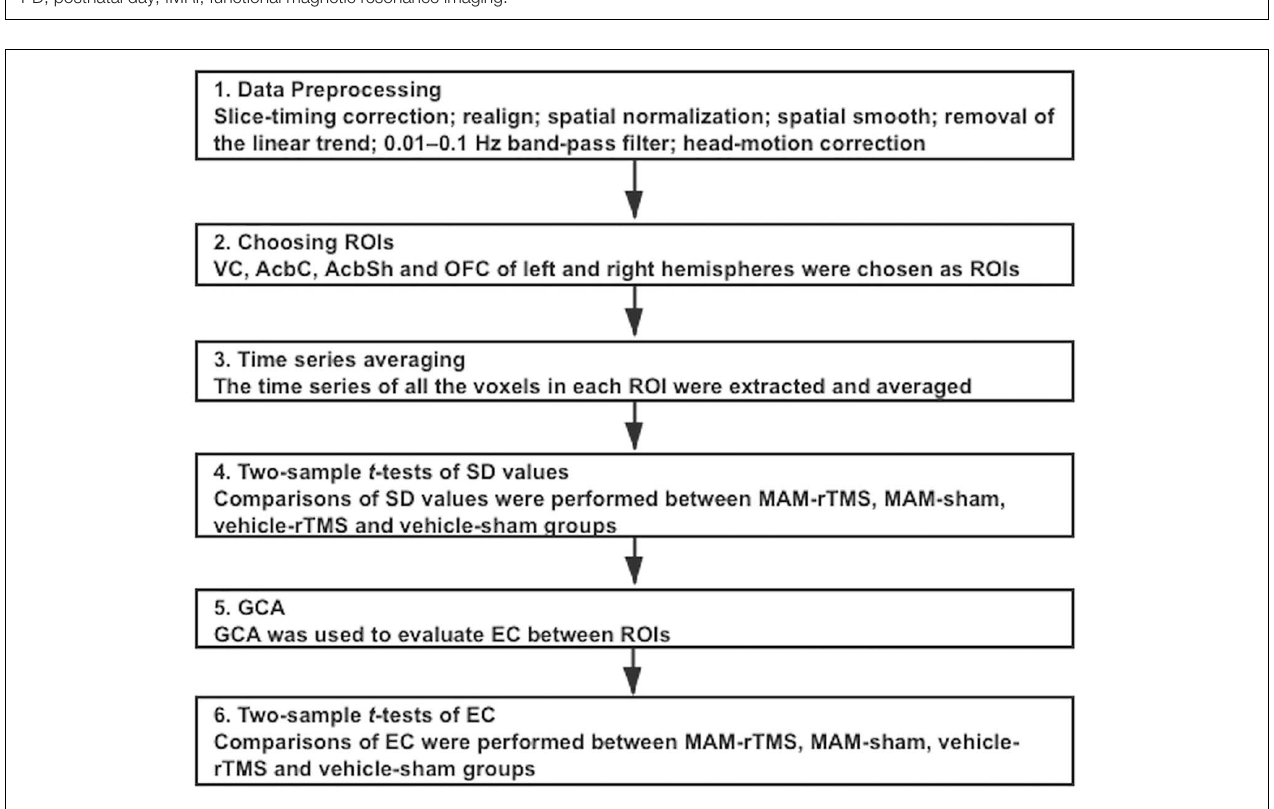
FIGURE 1 | The study design and technical route. E17, embryonic day 17; MAM, methylazoxymethanol acetate; rTMS, repetitive transcranial magnetic stimulation; PD, postnatal day; fMRI, functional magnetic resonance imaging.